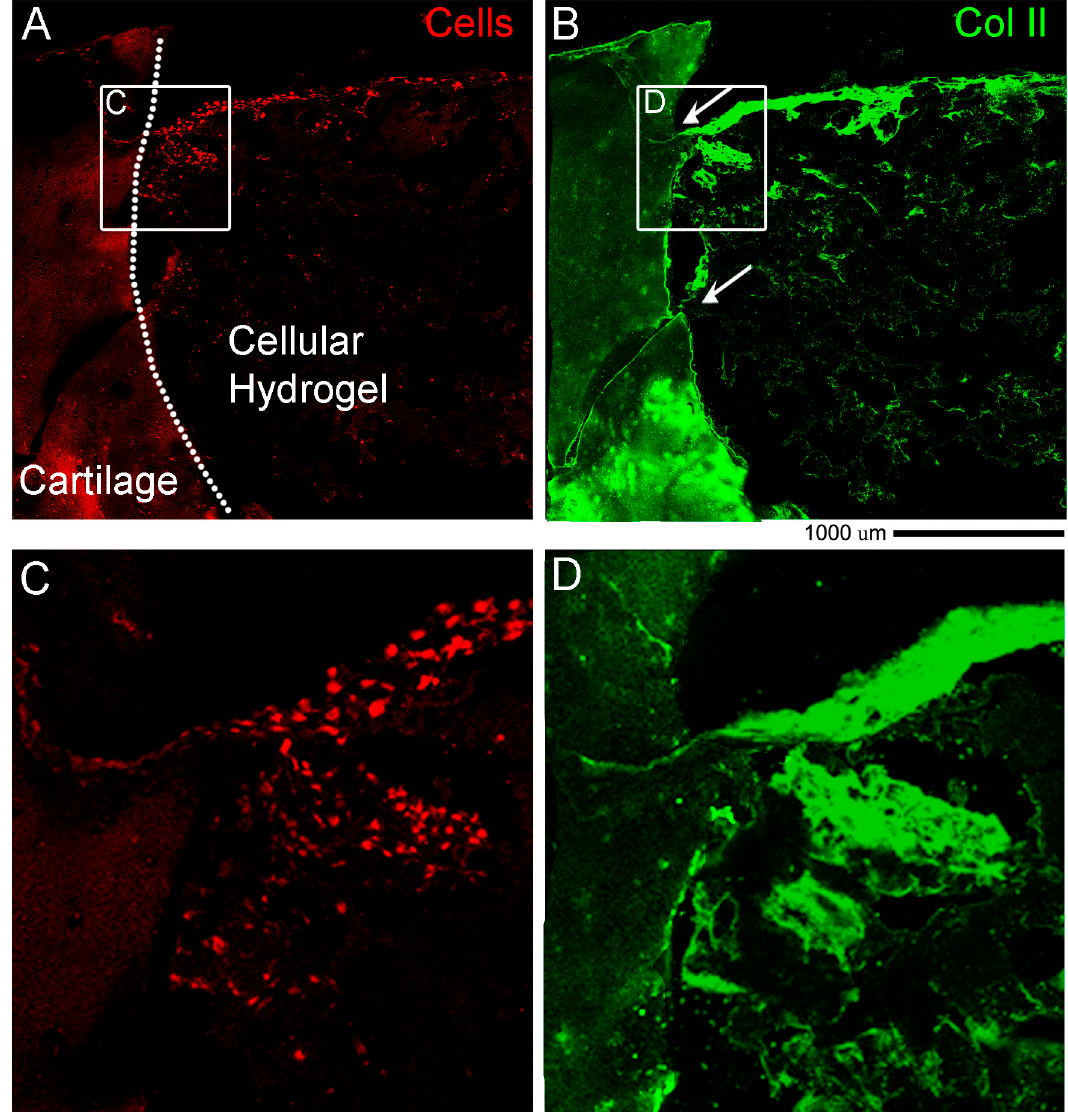
Figure 8. Representative fluorescent images of immunostaining performed on OCT sections of OC plugs filled with human Adipose Derived mesenchymal Stem Cells (hADSCs) cellular GelMa/HAMa hydrogel after 4 weeks of chondrogenic stimulation in the perfusion bioreactor. ( A ) Phalloidin-FITC actin staining is shown in red to mark cells in the hydrogel and in the native cartilage. ( B ) Collagen type II staining is shown in green and is clear evidence for the production and accumulation of hyaline like cartilage in the areas where the cells are aggregated. Arrows point to lateral integration areas between the scaffold and the cartilage. Scale bar 100 um corresponds to 100 µ m. ( C , D ) Higher magnification of ROI in A and B panels.